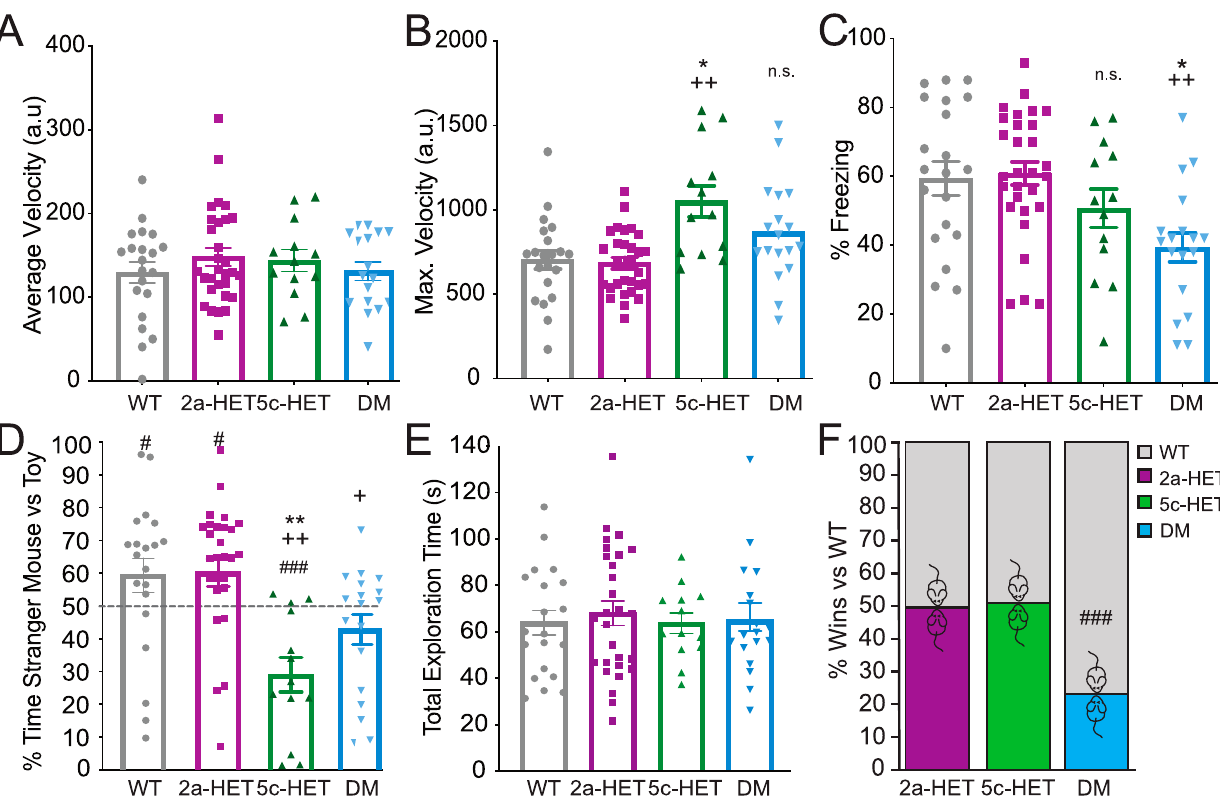
Figure 3. Altered memory and social phenotypes in Kdm5c-Het female mice are not rescued— and may be exacerbated—in double mutant mice. ( A – C ) Foreground context fear